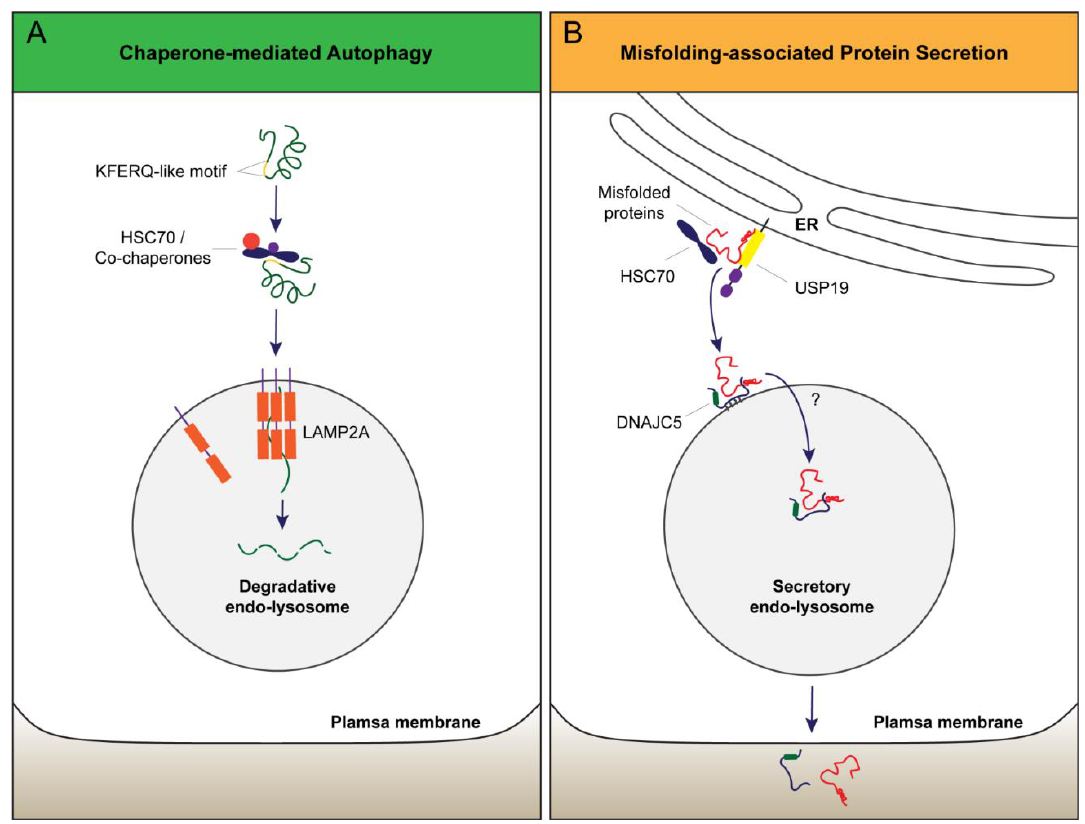
Figure 2. Models of protein transport into endo-lysosomes in CMA and MAPS. ( A ) CMA substrates bearing a KFERQ-like motif are recognized by cytosolic HSC70/co-chaperones. This complex is delivered to the lysosomal surface where the CMA receptor LAMP2A captures substrates via its cytoplasmic tail. Protein unfolding and LAMP2A multimerization are essential for the translocation of cargos into the lumen for lysosomal degradation. ( B ) In MAPS, an ER-associated protein with a chaperone activity (e.g., USP19) captures misfolded proteins. MAPS cargos are subsequently transported to the late endosomes by DNAJC5 (DnaJ heat shock protein family member C5), which associates with late endosome membranes via palmitoylation. DNAJC5 and the associated cargos are translocated into the lumen of vesicles by an unknown mechanism, but protein unfolding is not required for this process. Secretion through endo-lysosome releases DNAJC5 together with cargos into the extracellular space.